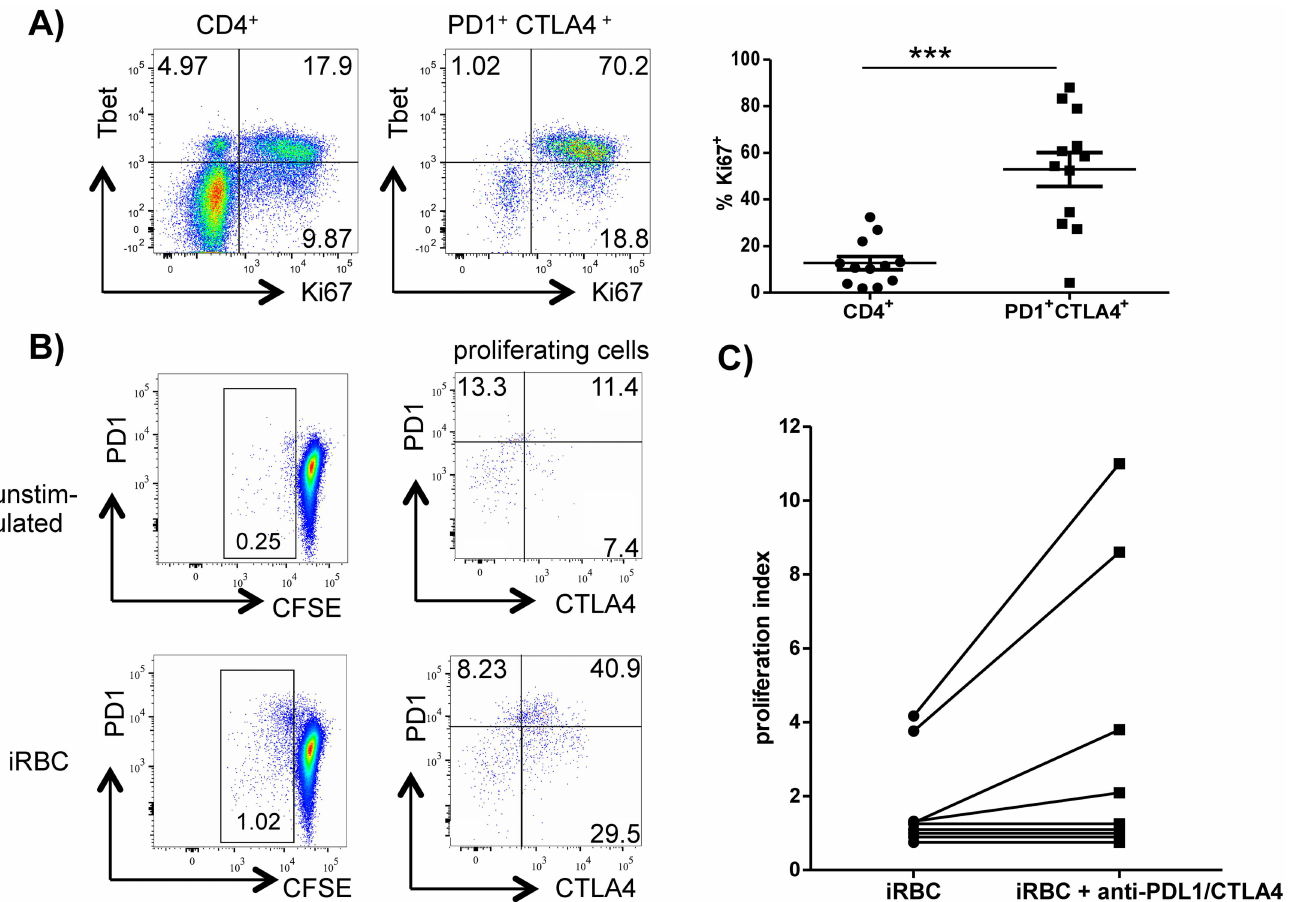
Fig 2. PD1 + CTLA4 + CD4 + T cells are malaria-specific. A) Whole blood samples of malaria patients were analyzedfor ex-vivo expression of intracellularKi67 and Tbet on CD4 + and PD1 + CTLA4 + CD4 + T cells. Dotplots show one representative donor out of 5. Scatter plots show the frequency of Ki67 expression on the assessed CD4 + T cells (left) and PD1 + CTLA4 + CD4 + T cells (right) for all malaria patients includedin the analysis(N = 12). *** P < 0.001. B) PBMC of malaria patients were labeledwith CFSE and stimulated with/without iRBC. Cells were first gated for CD4 + T cells. Proliferatingcells were further analyzedfor expression of CTLA4 and PD1. The assay is shown here for one representative malariapatient out of three. The other two patients are presented in S6 Fig. C) PBMC were stimulated with iRBC with/without the addition of 10 μ g/ml anti-PDL1 and anti- CTLA4 and 3 H uptakes measured after 120hrs of culture. Proliferationindices were calculated by dividing 3 H counts of stimulated cells by 3 H counts of unstimulatedcells. A proliferation index > 2 was consideredto be a positive response. (n =